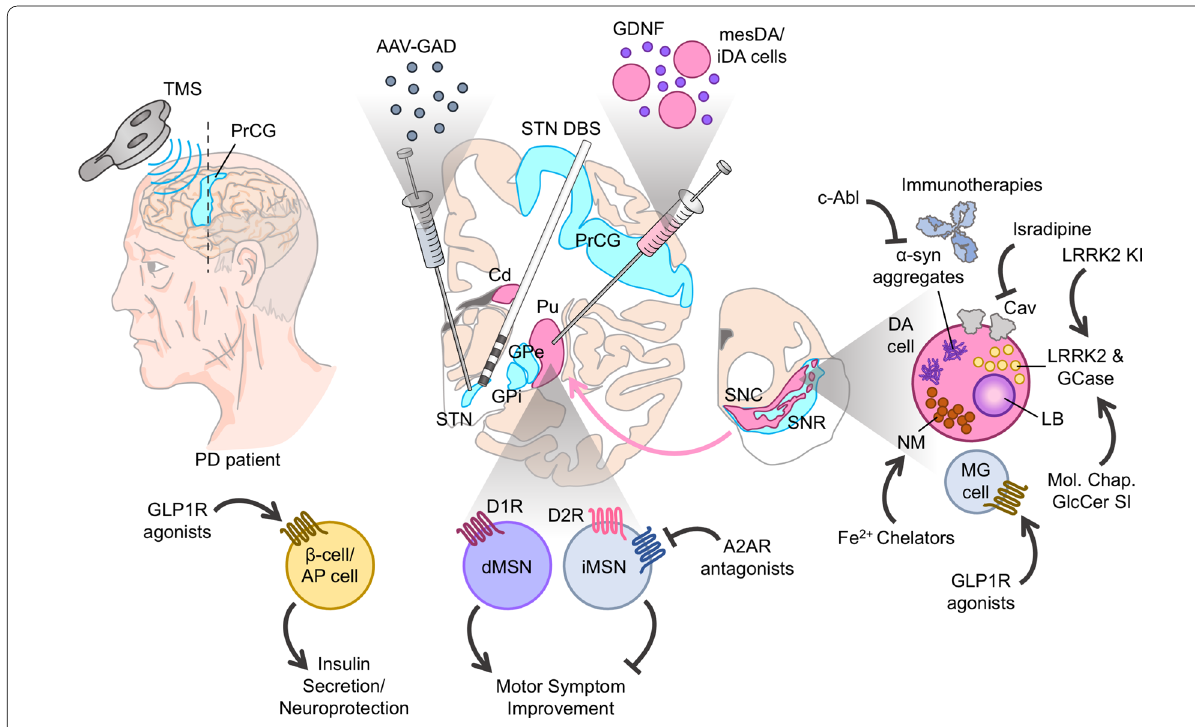
Fig. 1 Potential neuroprotective mechanisms of novel targeted therapies in Parkinson’s disease. AAV adeno‑associated virus, AP area postrema, A2AR adenosine A2A receptor, Cd caudate nucleus, DA cell dopaminergic cell, DBS deep brain stimulation, dMSN direct pathway medium spiny neurons, D1R dopamine D 1 receptor; D2R dopamine D 2 receptor; GAD glutamate decarboxylase; GCase glucocerebrosidase, GDNF glial cell‑line derived neurotrophic factor, GLP1R glucagon‑like peptide 1 receptor, GPe globus pallidus externa, GPi globus pallidus interna, iMSN indirect pathway medium spiny neurons; KI kinase inhibitor, LB lewy body, LRRK2 leukine‑rich repeat kinase 2, MG microglia, NM neuromelanin; PrCG pre‑central gyus, Pu putamen; SNC substantia nigra pars compacta, SNR substantia nigra pars reticulata, STN subthalamic nucleus, TMS transcranial magnetic